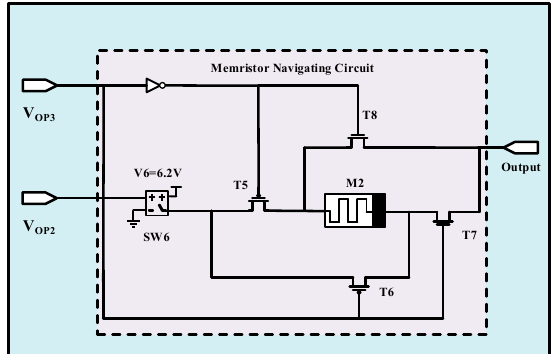
Figure 6. The circuit-level implementation of modeled Synapse 3 consisting of two operating signals, a switch, and Memristor 2 (M2).